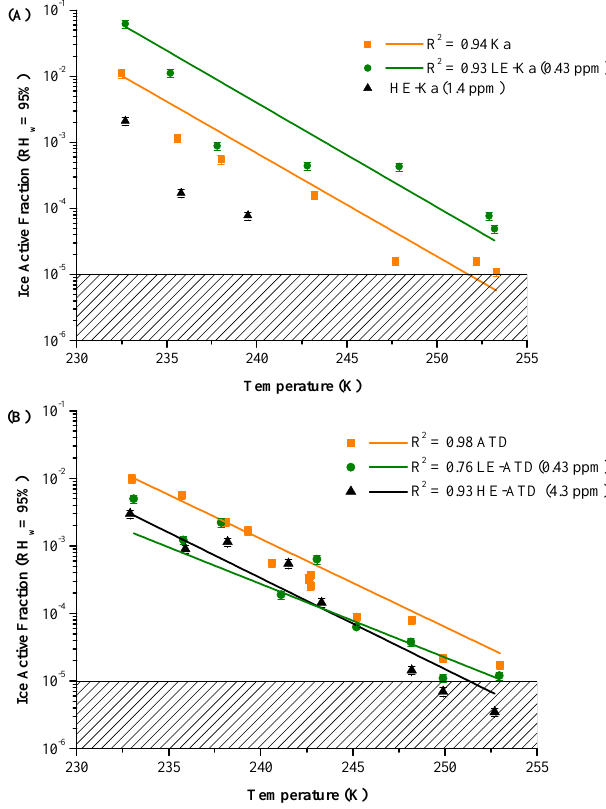
Fig. 7. Ice activated fraction at RH w = 95% as a function of tem- perature for deposition mode nucleation of (A) Ka and (B) ATD. Exponential fit equations for curves are presented in Table 3. Hashed region represents instrument detection limit for PINC. A fit for the HE-Ka was not calculated obtained because of the few data points